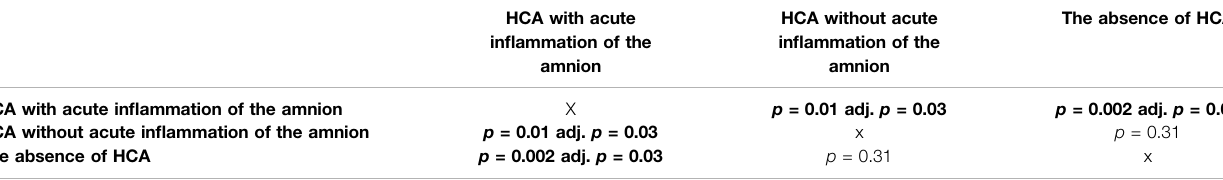
TABLE3| Comparisonsofthepercentilesofbirthweightsofnewbornsderivedfromtheestimatedfetalweightstandardsamongthesubgroupsofwomenwiththepresence of HCA with and without acute in fl ammation of the amnion and those with the absence of